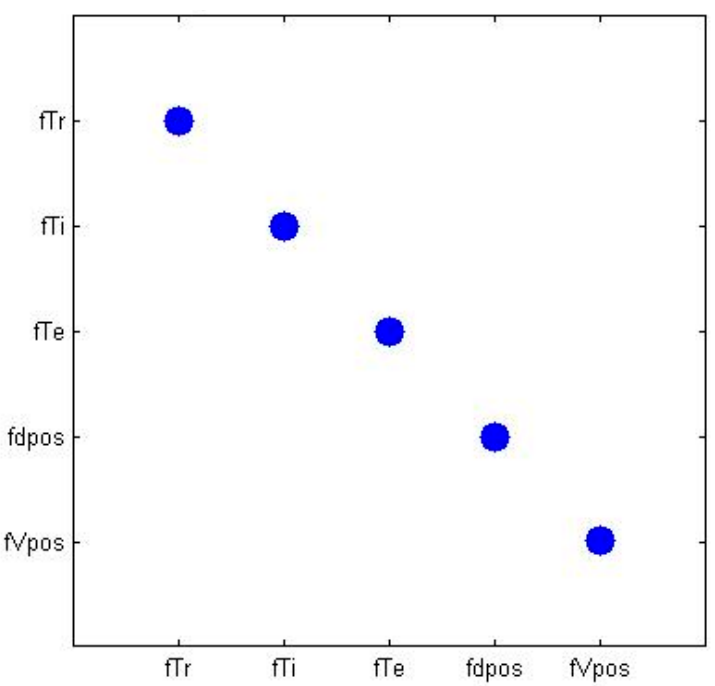
Figure 5. Isolability matrix for scenario 2 with additional sensors added. Fully isolability has been obtained by adding sensors at location T e , d pos and V pos .